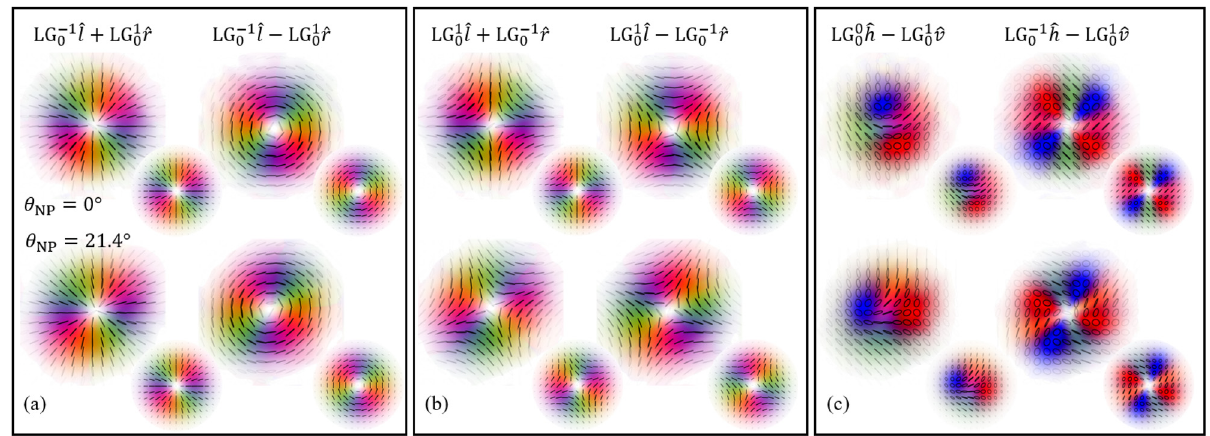
Figure 5: Polarisation plots of experimentally measured vector beams before (top row) and after (bottom row) the system, for a fixed rotation angle of 𝜃 = (21 . 4 ± 0 . 5) ◦ . Beams in (a), and (b) contain only linear polarisation and are of the form LG ± 1 The first column in (c) is a Poincaré beam and the second column shows a beam containing polarisations along a great circle on the Poincaré sphere. Smaller inserts show the corresponding theory plots, and we have used the polarisation colour scheme from Figure 4 in order to aid the